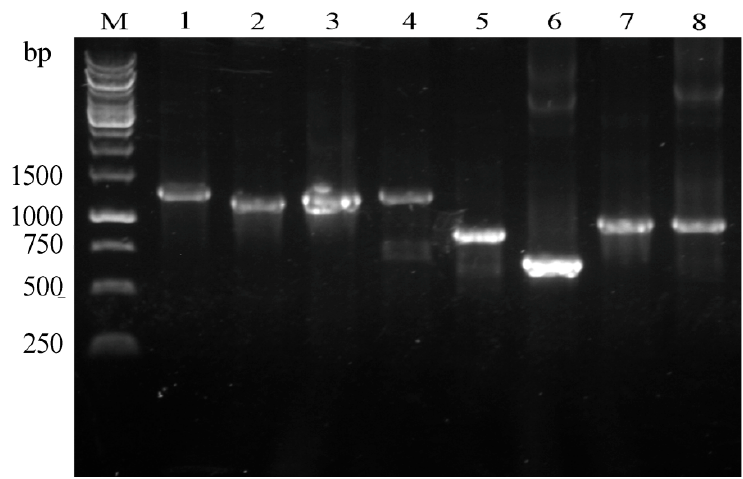
Figure 1. Full-length cDNAs of the eight studied PgWRKYs ( PgWRKY2-9 ). M: Marker (1 kbp DNA